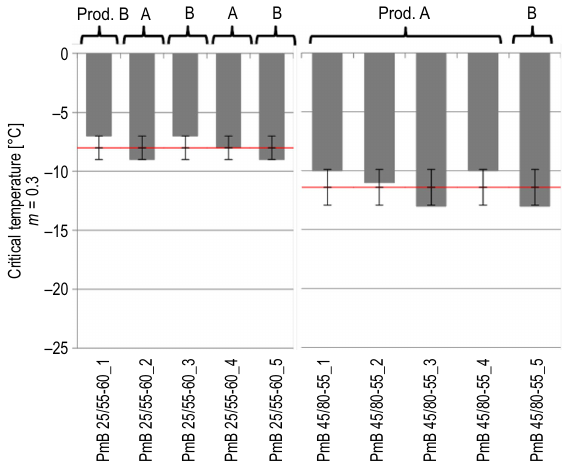
Fig. 12. Polymer modified bitumen critical temperature according to BBR ( m = 0.300)